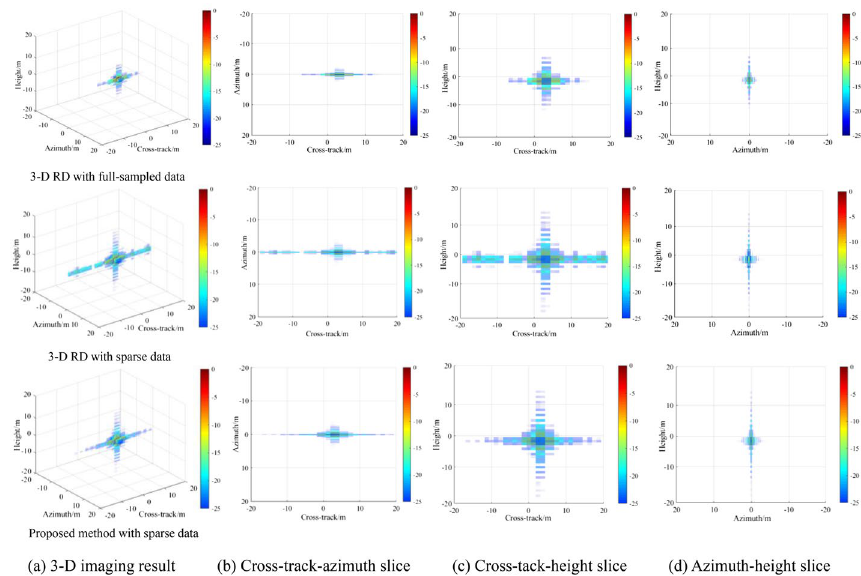
Fig. 4 3D imaging results of 3D RD and proposed method with 100% data or 50% sparse data. The SNR is set as 10 dB. The limited amplitude is 25 dB −